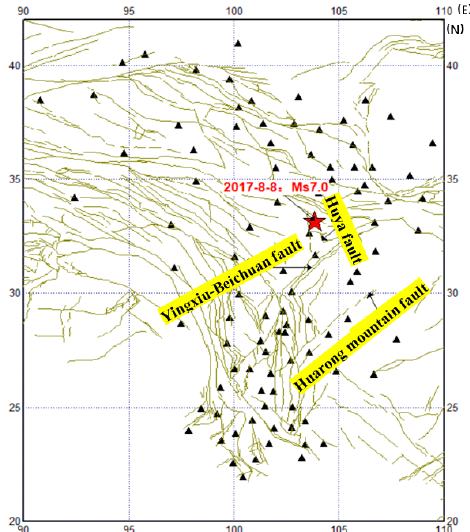
Figure 2. Distribution of Global Navigation Satellite System (GNSS) base stations in the eight provinces around the 2017 M w 6.5 Jiuzhaigou earthquake. Black triangles show the locations of GNSS base stations, and the red star shows the epicenter location.